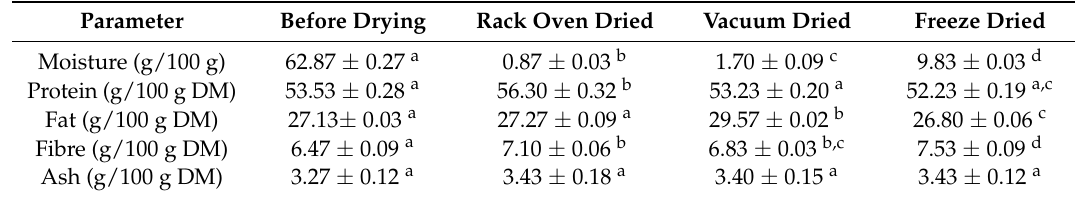
Table 1. Nutritional values of fresh and dried mealworm larvae.